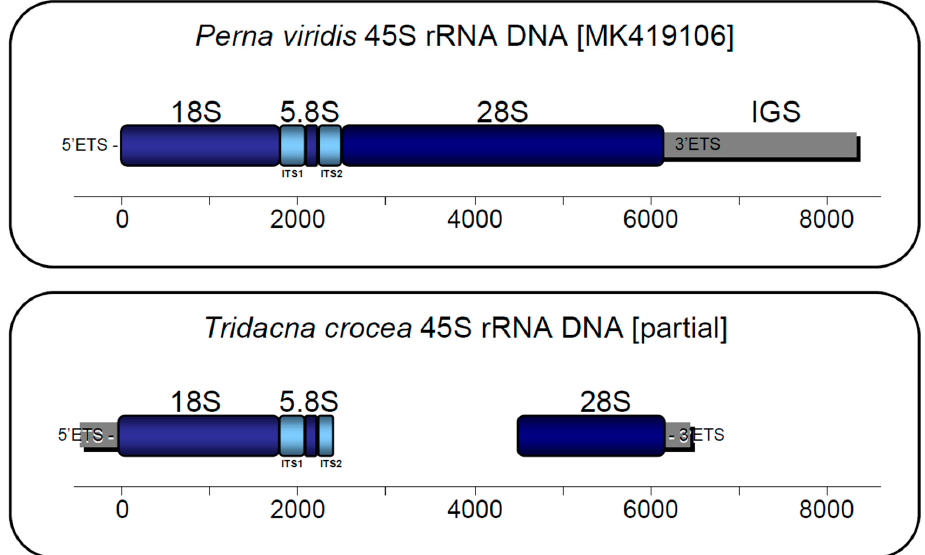
Figure 3. Partially assembled 45S rRNA DNA of Tridacna crocea and comparison with the complete 45S rRNA DNA of Perna viridis (GenBank accession number: MK419106.1).